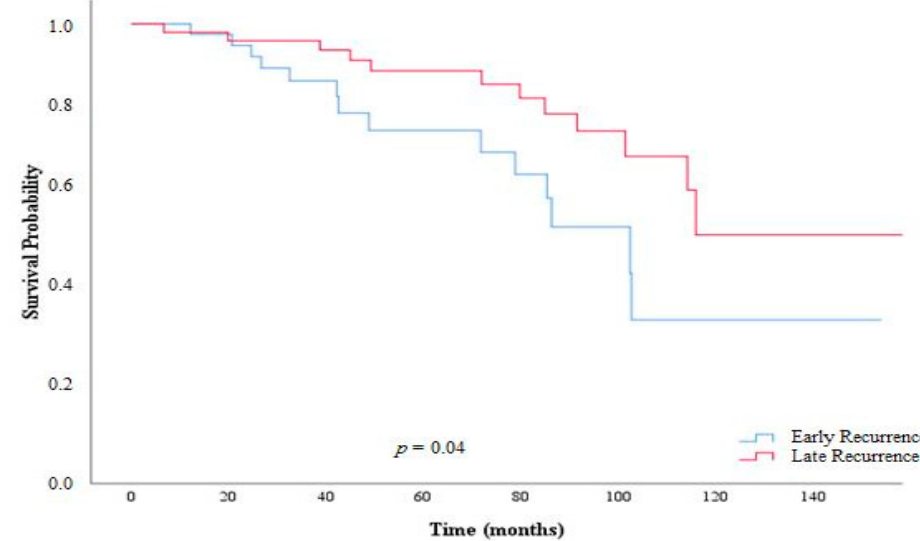
Figure 2. Kaplan–Meier curves demonstrating differences in PRS among patients with early versus late recurrence.